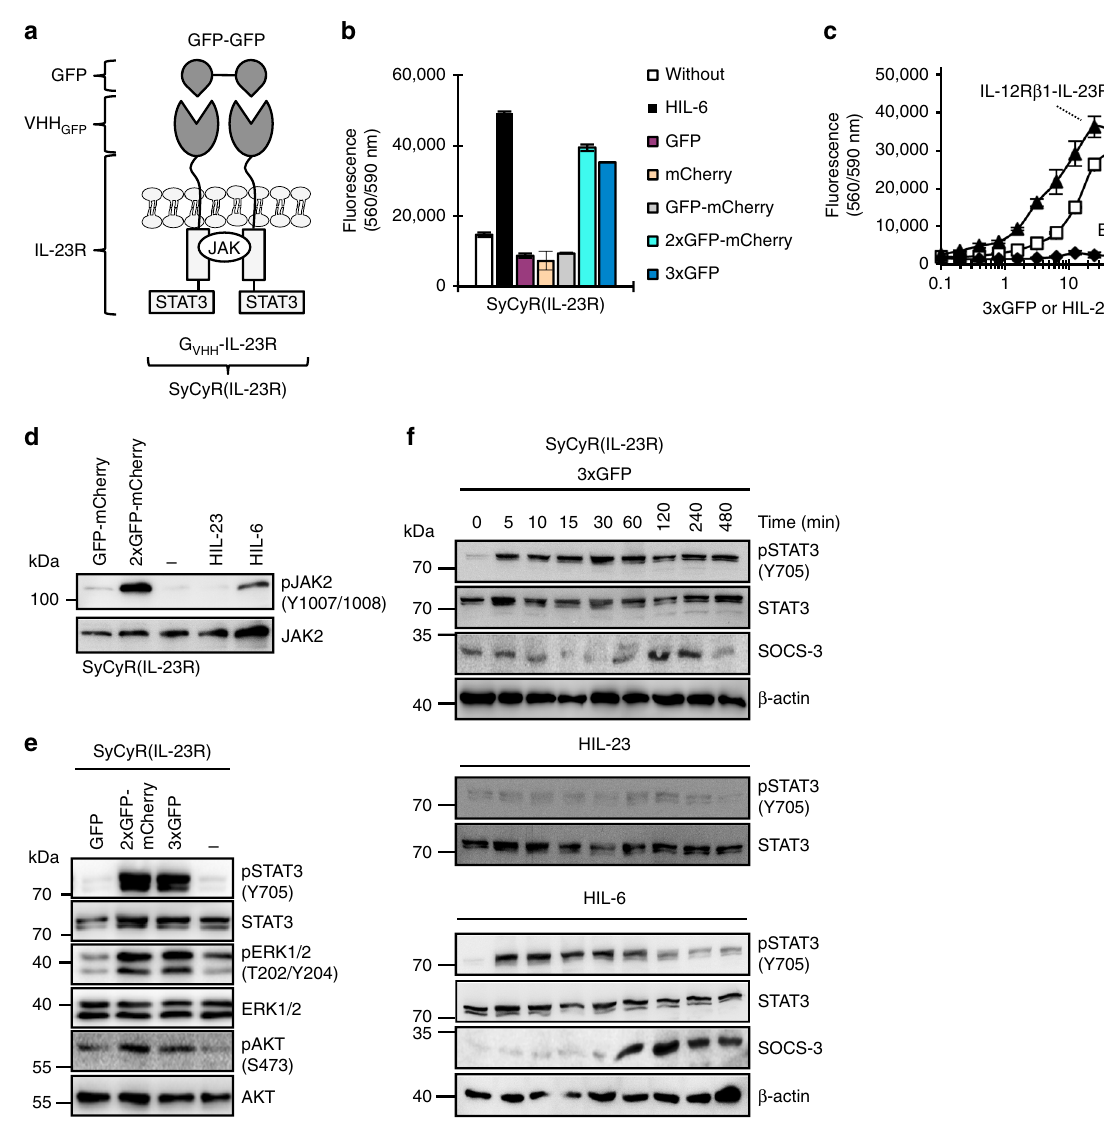
Fig. 5 SyCyRs for homodimeric IL-23R (SyCyR(IL-23R)) induced signal transduction. a Schematic illustration of homodimeric IL-23R SyCyR and GFP-GFP fusion protein. G VHH -IL-23R: G VHH fused to 17 aa of the ECD, TMD, and ICD of IL-23R. b Proliferation of Ba/F3-SyCyR(IL-23R) cells with HIL-6 and GFP: mCherry fusion proteins cultured in the presence of the indicated synthetic ligands (6.25 ng/ml) or HIL-6 (10 ng/ml). Stimulation with mCherry was made with the same volume as with GFP (0.25%). One representative experiment out of three is shown. Results are mean ± s.d. of three replicates. c Proliferation of Ba/F3-SyCyR(IL-23R) with HIL-23, Ba/F3-IL-12R β 1-IL-23R, and Ba/F3-gp130 cells with 3xGFP and HIL-23 cultured in the presence of ligands (0.1 to 1600 ng/ml). One representative experiment out of six is shown. Results are mean ± s.d. of three replicates. d JAK activation in Ba/F3-SyCyR(IL-23R) cells. Cells were stimulated with conditioned supernatants containing 100 ng/ml of the indicated synthetic ligands or HIL-6 (100 ng/ml) for 20 min. Equal amounts of total protein (50 μ g/lane) were analyzed for phospho-JAK2 and JAK2. Western blot data show one representative experiment out of three. e STAT3, ERK1/2, and AKT activation in Ba/F3-SyCyR(IL-23R) cells stimulated with 100 ng/ml of the indicated ligands for 30 min. Stimulation with mCherry was made with the same volume as with GFP (2%). Equal amounts of total protein (50 μ g/lane) were analyzed for phospho-STAT3/ERK1/2/AKT and STAT3/ERK1/2/AKT. Western blot data show one representative experiment out of three. f Ba/F3-SyCyR(IL-23R) cells were stimulated with 3xGFP (100 ng/ml), HIL-23 (25 ng/ml), and HIL-6 (25 ng/ml) for 0 – 480 min. Equal amounts of total protein (50 μ g/lane) were analyzed for phospho-STAT3, STAT3, SOCS3, and β -actin. Western blot data show one representative experiment out of